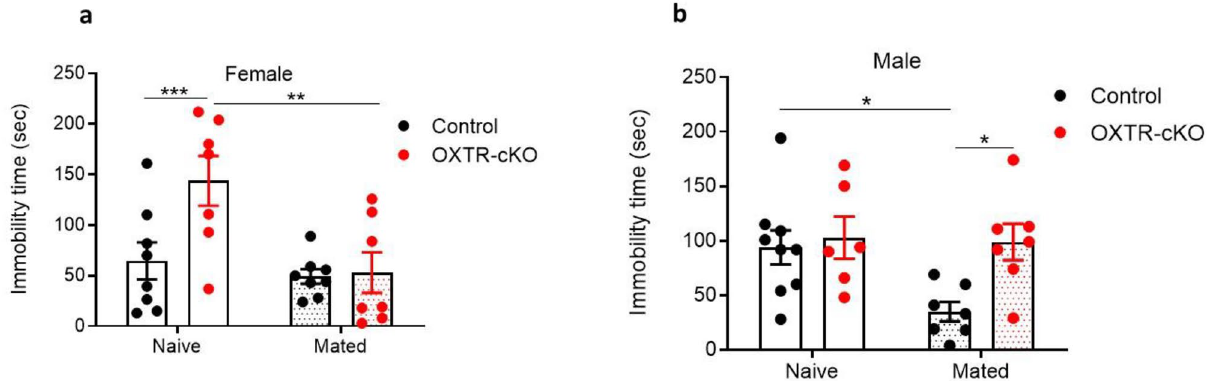
Figure 7. Anti-depressant effect of mating is sex-dependent and is abolished by OXTR deletion from MCH neurons. ( a ) Effect of mating on immobility times in female control and OXTR-cKO mice, n control = 8, n OXTR-cKO = 7, ** P < 0.01, *** P < 0.001, two-way ANOVA analysis, followed by Tukey’s multiple comparisons test. ( b ) Effect of mating on immobility times in male control and OXTR-cKO mice, naive: n control = 7, n OXTR-cKO = 7, * P < 0.05, two-way ANOVA analysis, followed by Tukey’s multiple comparisons